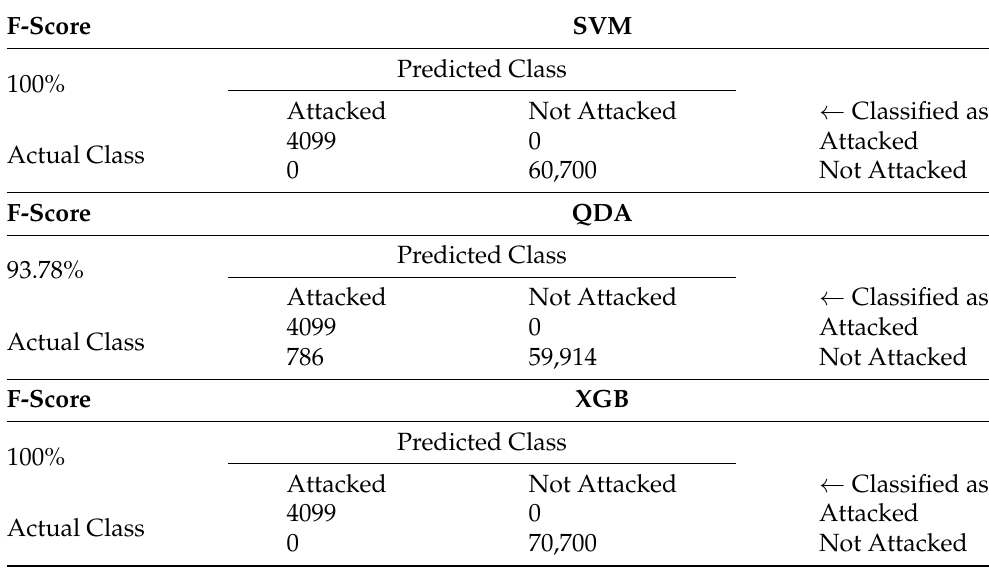
Table 5. Sample of the performance for scenario I.